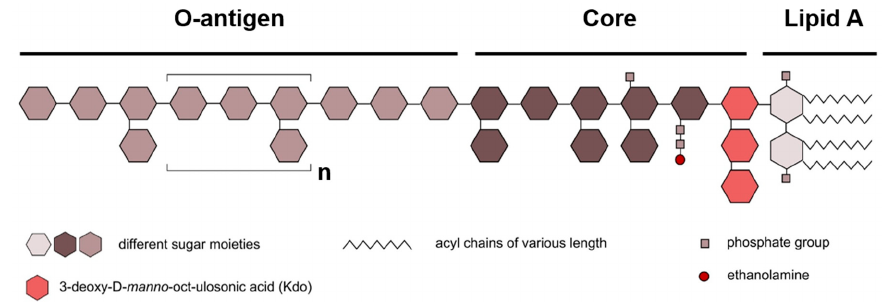
Figure 4. Schematic diagram of the general LPS structure. Lipopolysaccharides consist of three main subunits: lipid A, the core region and the O-antigen. The number and chemical structure of the acyl chains can vary. Sugar moieties are depicted as hexagons in different colors. The number and chemical nature of these sugars can differ (Modified from Steimle et al.